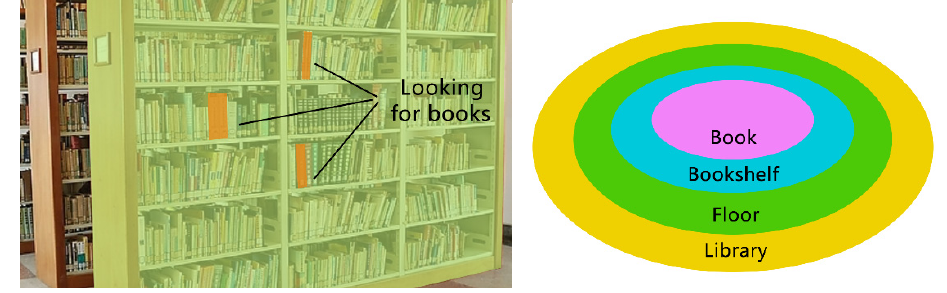
Figure 7. Looking for books in a library.